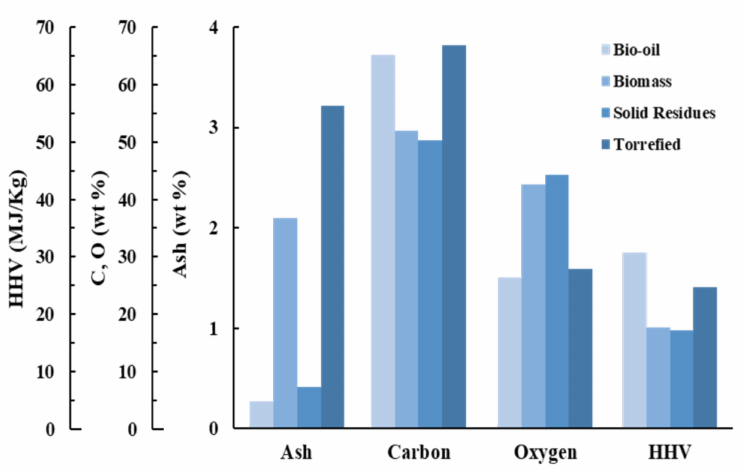
Figure 2. Comparison of the average ash, carbon, oxygen contents, and HHV between bio-oils, biomass, solid residues, and torrefied